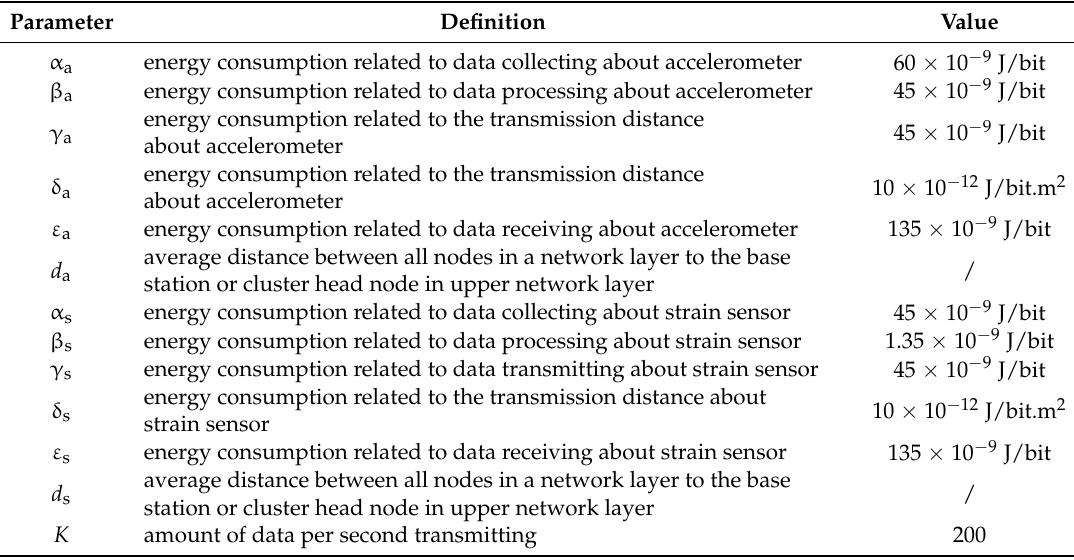
Table 2. Nomenclature and typical